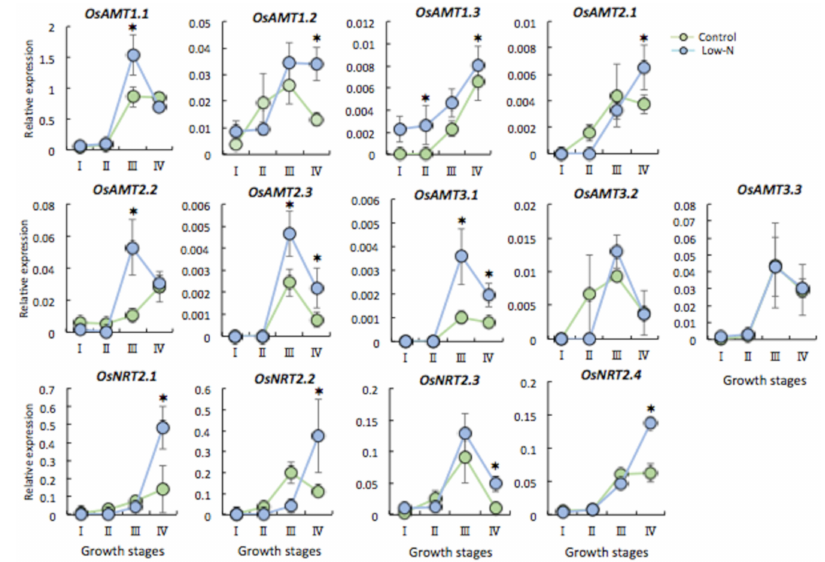
Figure 4. Relative expression of N transporter genes (NH 4 + transporter genes, AMT; NO 3 − transporter genes, NRTs) in root. I, II, III, and IV refer to before and after topdressing at tiller initiation and early panicle formation stages. Each point represents the mean value, error bars indicate mean ± SD of 5 replicates. * Significant di ff erence ( p < 0.05, Student’s t